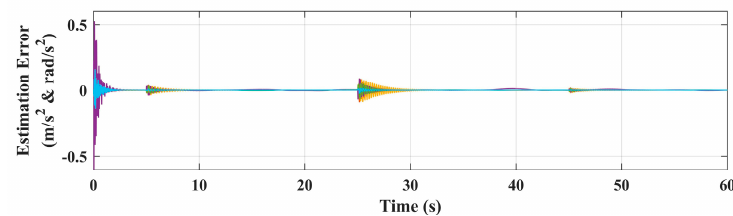
Figure 8. Estimation error of the adaptive controller.